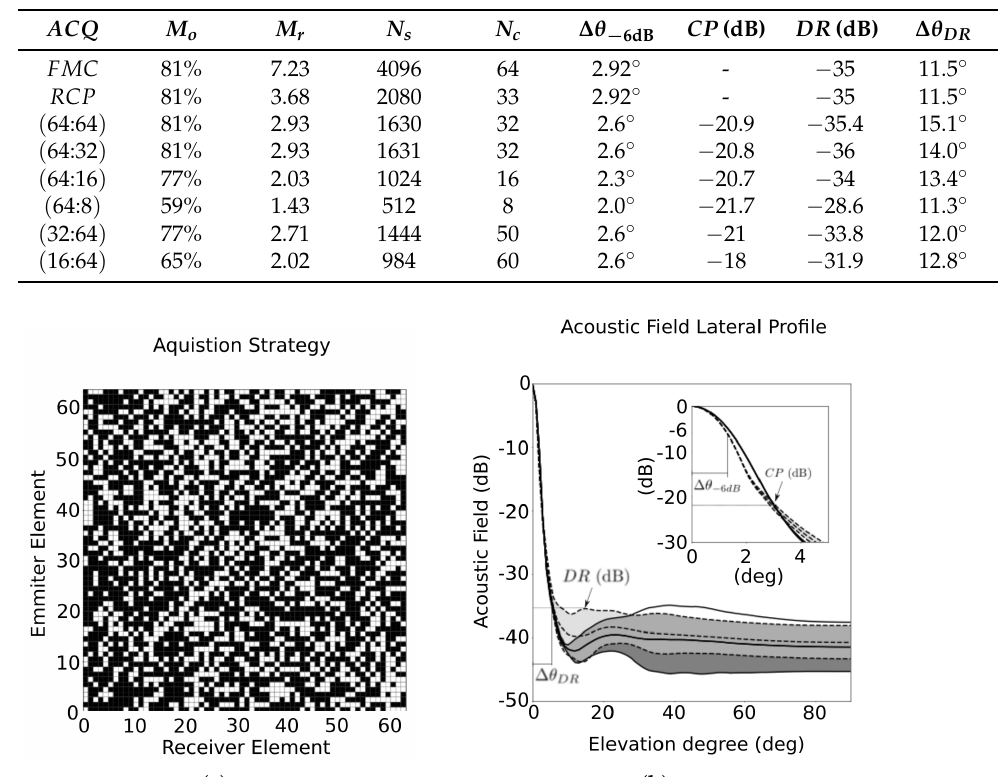
Table 1. Fermat spiral array: performance for the FMC , RCP and all six strategies considered ( Tx : Rx ).